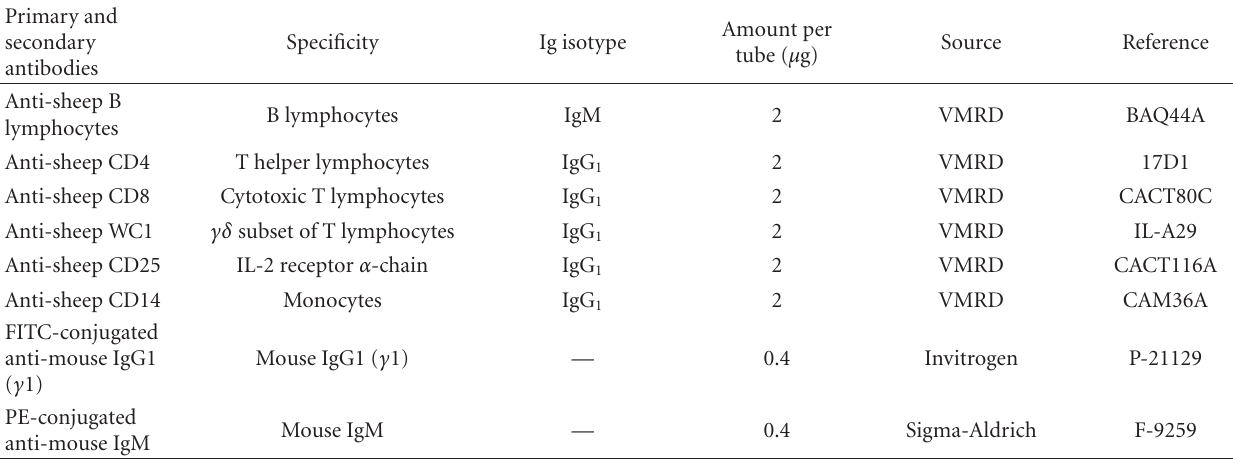
Table 1: Antibodies used to analyze PBMC populations by flow